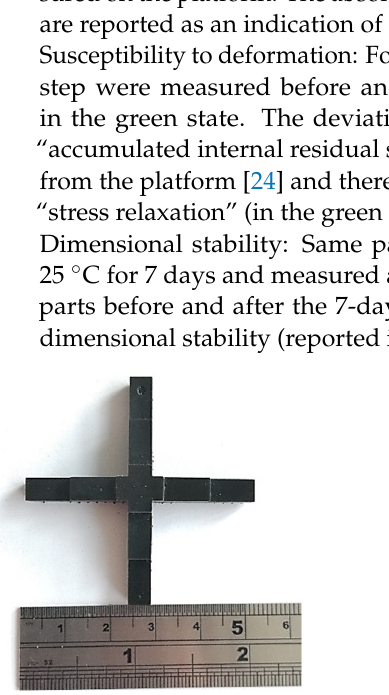
Figure 3. The printed cross-shaped dimension model used in this work, adapted from Weng et al. [23.]